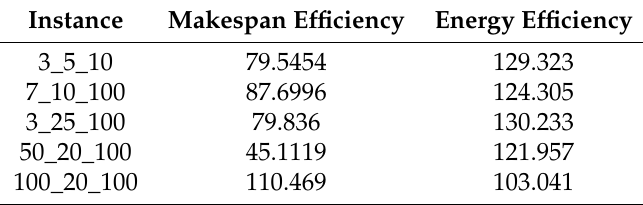
Table 4. Makespan and energy efficiency of the proposed